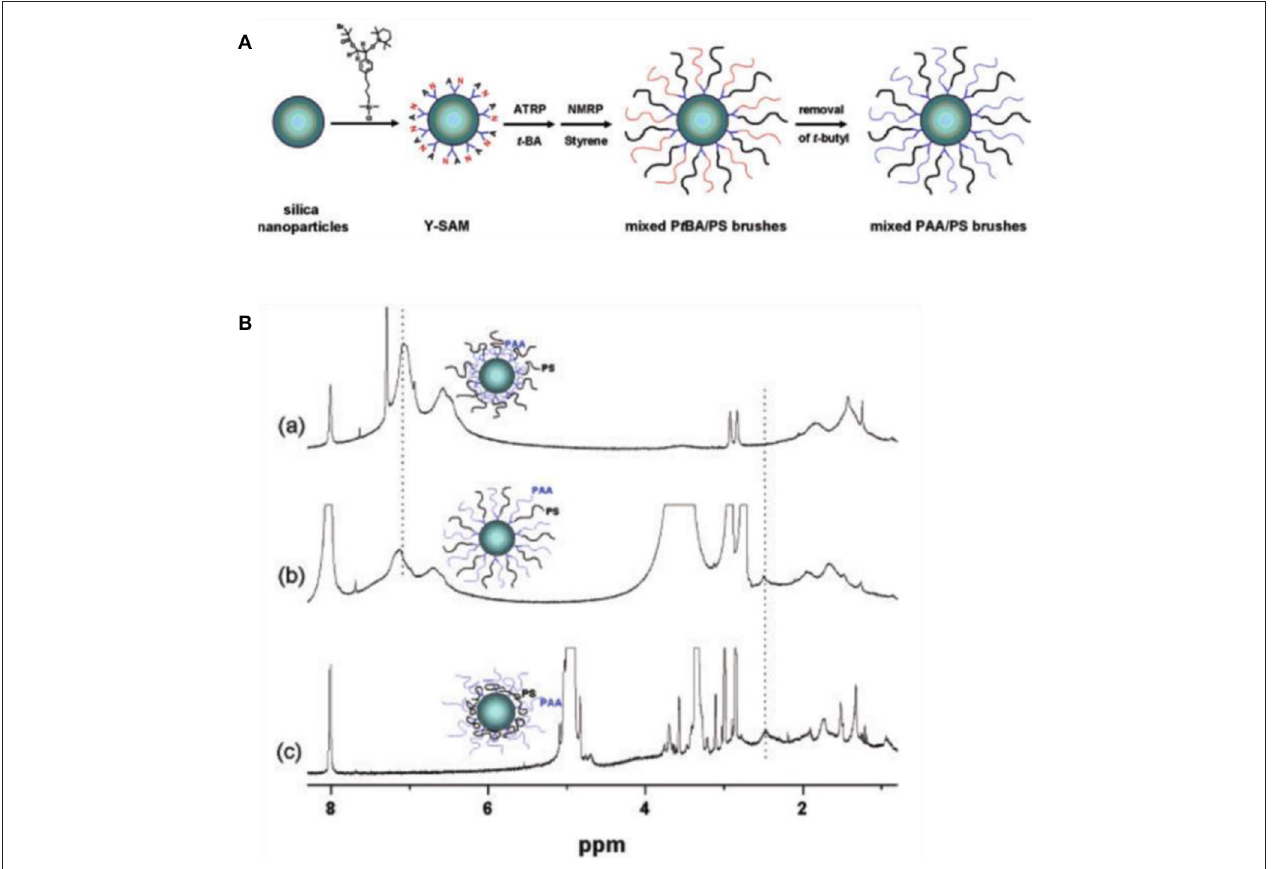
FIGURE 9 | Schematic illustration of mixed polymer brushes on silica nanoparticles (A) and environmentally responsive properties of hairy particles in different deuterated solvent demonstrated by 1 H NMR ( Li et al., 2005). (B) 1 H NMR spectra of PAA/PA particles dispersed in (a) CDCl3, (b) DMF-d7, and (c) CD3OD. Reprinted with permission from Li et al. (2005). Copyright 2005 American Chemical